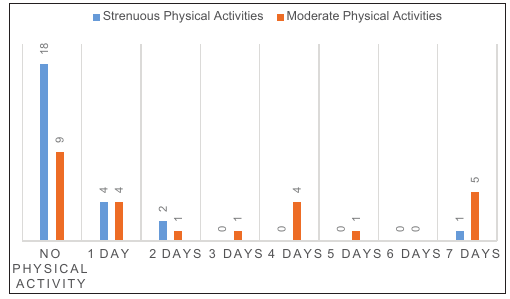
CHART 14. Frequency of physical activities in free time in a week. (Strenuous Physical Activities Moderate Physical Activities)